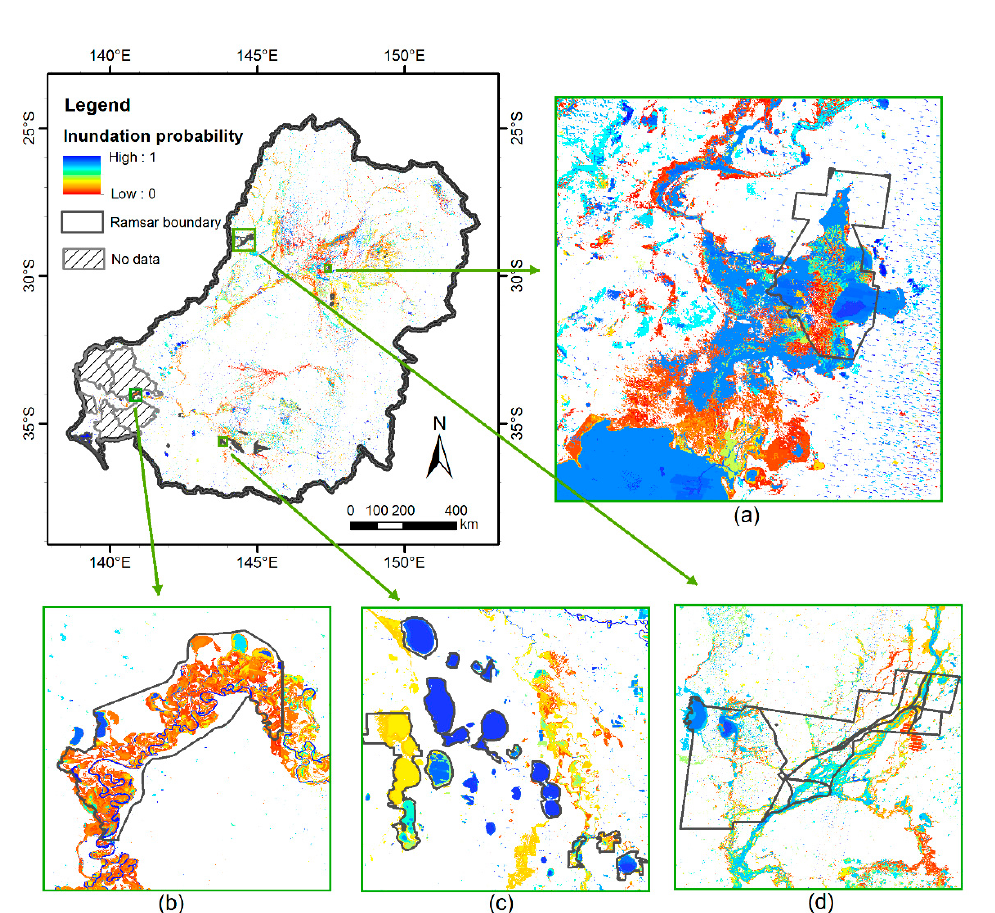
Figure 5. Flood inundation probability in MDB, ( a ) Narran Lake Nature Reserve, ( b ) Riverland, ( c ) Kerang Wetlands ( d ) Currawinya Lakes.